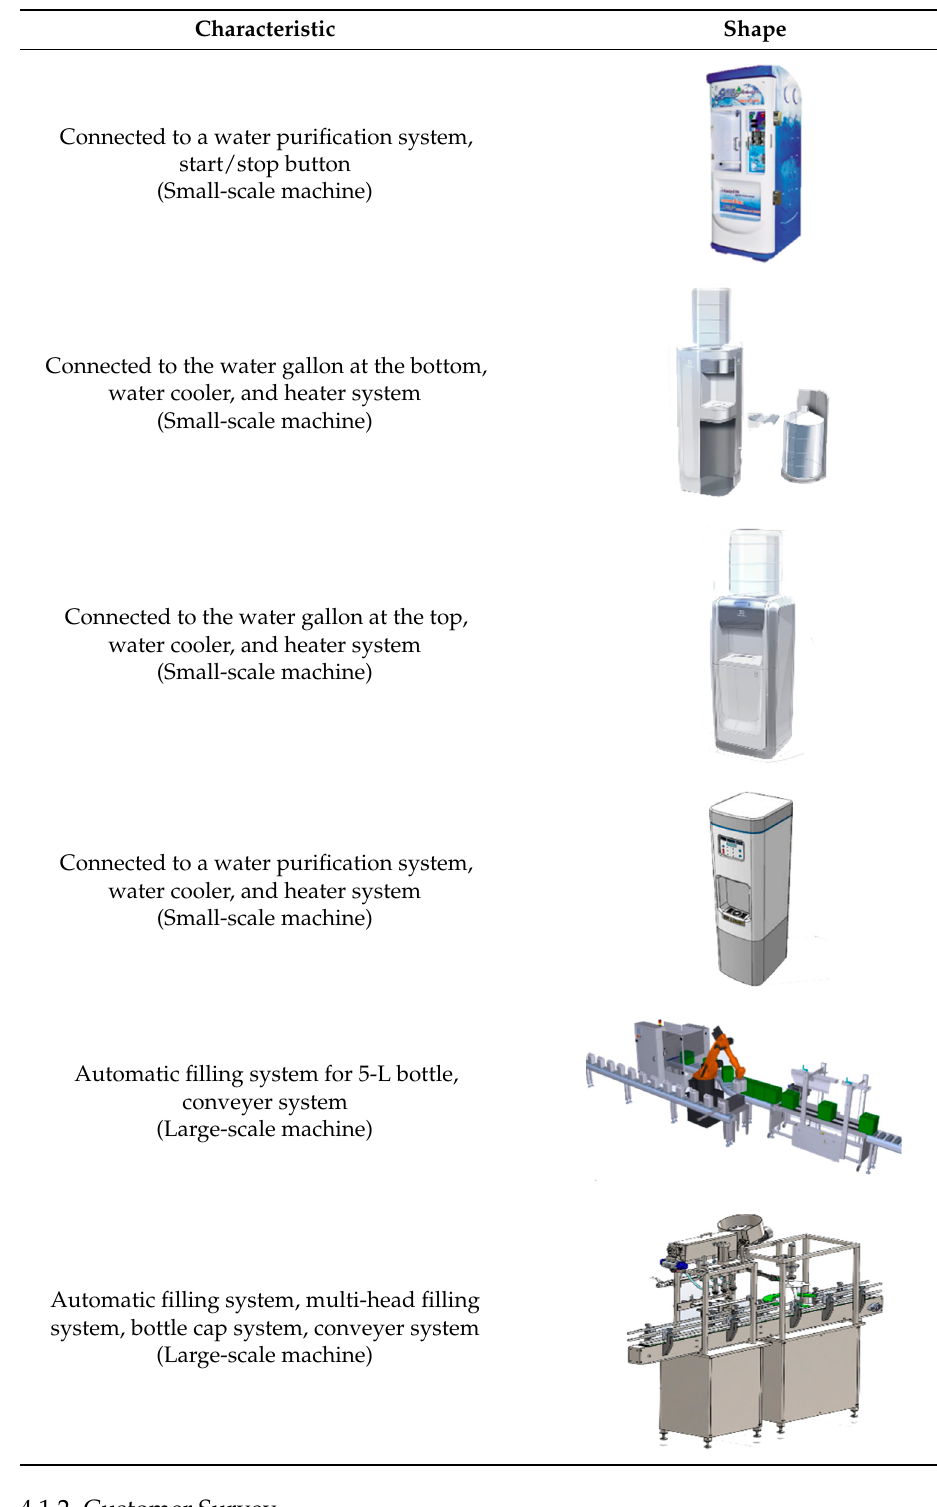
Figure 5. Steps required for creating self-administered questionnaires. The researchers have studied the perceptions and behaviors of people who live in the capital city (i.e., the Bangkok metropolitan region) and the survey questions were con- structed to assess how people feel about water filling machines, and how many of them decided to purchase bottled water. The researchers did not have much information on the subject to begin with, so as- sumed that half of the respondents purchase bottled water; this gave us maximum varia- bility. We used the following equation (Equation (11)) [40]: (cid:4672) ((cid:3027)) (cid:3118) × (cid:3043) × (cid:3044) ((cid:3032)) (cid:3118)